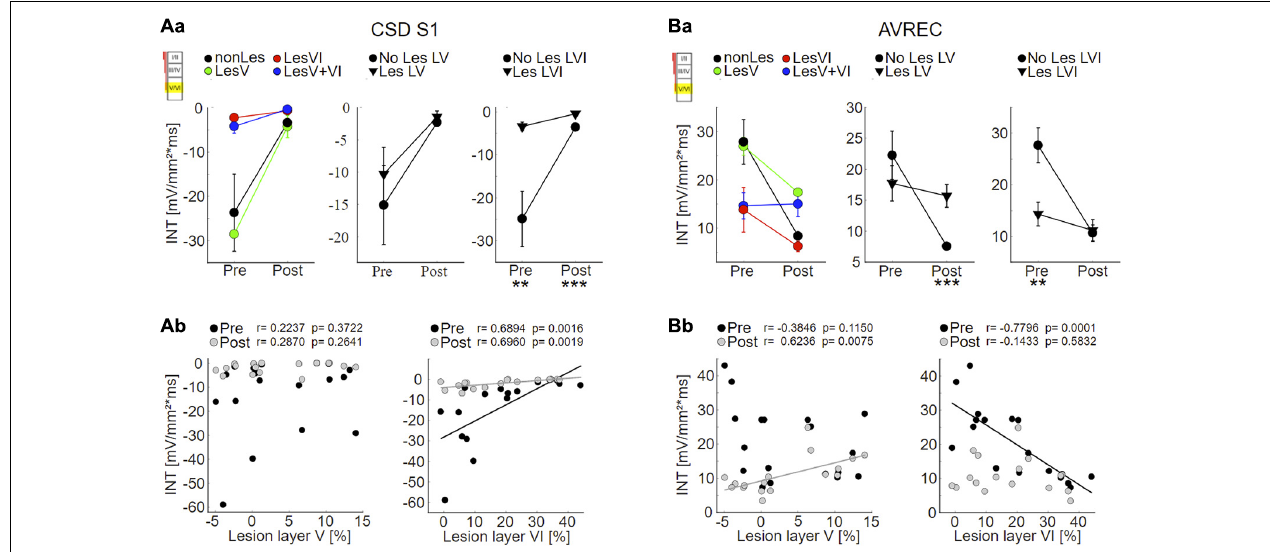
FIGURE 6 | Effects of layer VI and layer V CT lesions on electrically evoked cortical activity (infragranular ICMS). (A) Effects on sink S1. (Aa) S1 means+SEM of all four groups (left), of layer V lesioned (groups LesV and LesV+VI) vs. non-layer V lesioned animals (middle), and of layer VI (groups LesVI and LesV+VI) vs. non-layer VI lesioned animals (right). (Ab) Individual S1 INT plotted against lesion strengths in layer V (left) or VI (right), before (black) and after (gray) application of muscimol. Animals with loss of layer VI CT neurons had weaker (less negative) granular sinks, both before and after cortical silencing. (B) Effects on AVRECs. (Ba) AVREC group means and (Bb) scatterplots as described for (A). Before silencing, strongest activation was evoked in animals without cell loss in layer VI. After application of muscimol, highest activity was seen in animals having lesions in layer V. Significant group comparisons (Aa,Ba) using a linear mixed effects model ( Supplementary Table 2A ) are labeled by asterisks (* p < 0.05, ** p < 0.01, *** p <